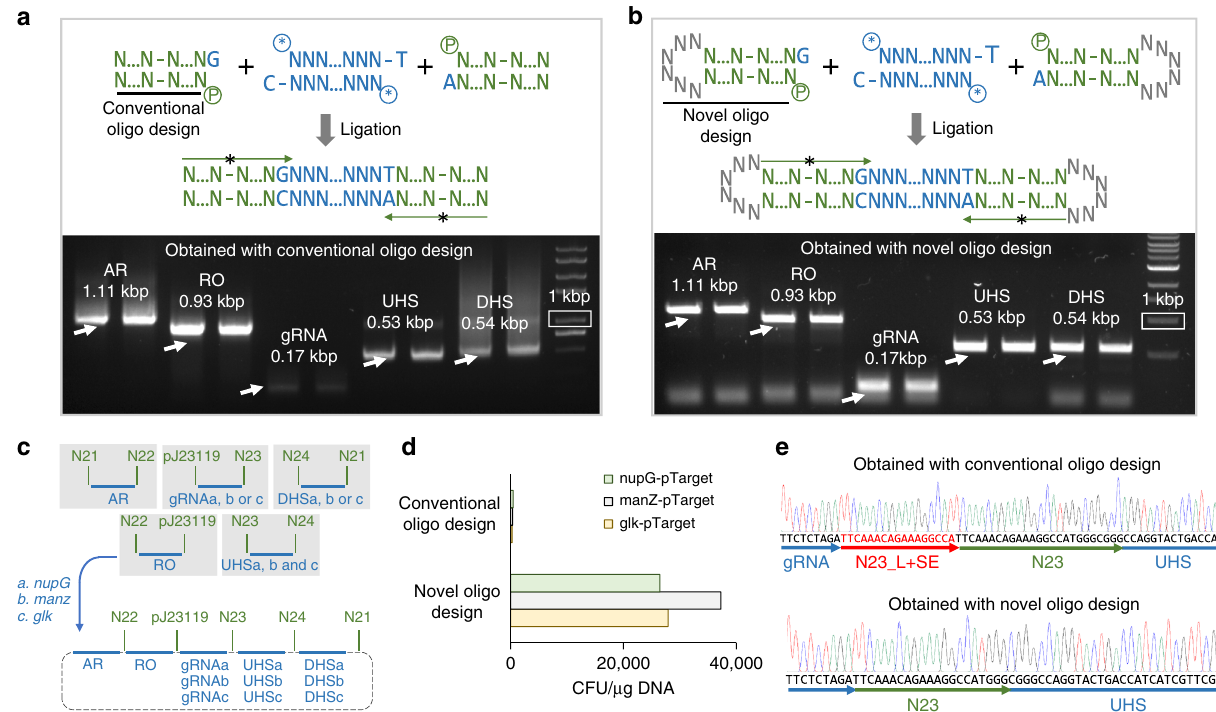
Fig. 2 Development of a near-scarless barcoding method. Work fl ow of barcoding a fragment by using conventional a and novel b oligos designs. After the ligation, barcoded fragments were ampli fi ed by using two Aoligos (shown as long black arrow with *) that bind barcodes. Analysis of PCR products from a and b using gel electrophoresis are shown. White arrows indicate the desired bands, and one sample was loaded into two lanes. DNA marker with 1 kbp size is highlighted in white rectangular box. The lane symbols are explained below. c The three plasmids used to compare the two barcoding methods. Each of the three plasmids can be used to delete a gene in E. coli ( nupG , manZ or glk ) by using CRISPR/Cas9 technology, and was constructed from fi ve fragments (blue thick horizontal bars represent fragments): antibiotic resistance marker (AR: Spec R ), replication origin (RO: pMB1), guide RNA (gRNA), upstream homologous sequence (UHS), and downstream homologous sequence (DHS). Green texts indicate barcode; N21, N22, N23, and N24: